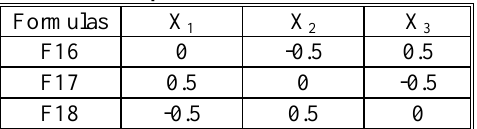
Table 3: Checkpoint formulas